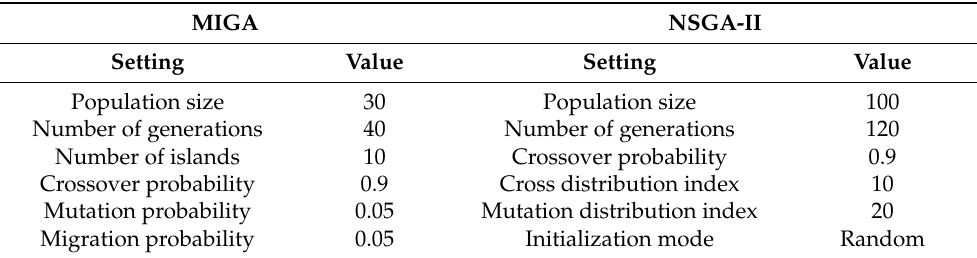
Table 3. Parameters setting for MIGA and